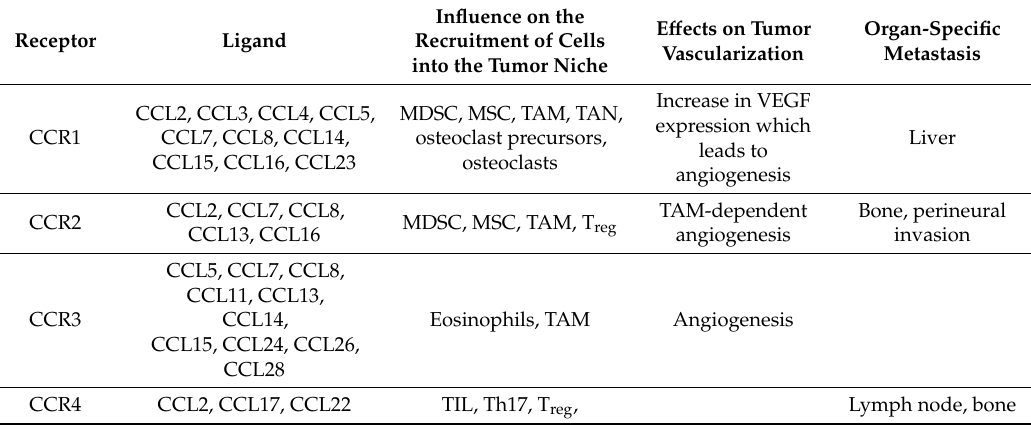
Table 4. Receptors of CC chemokines discussed in this part of the paper, with their ligands and functions in a